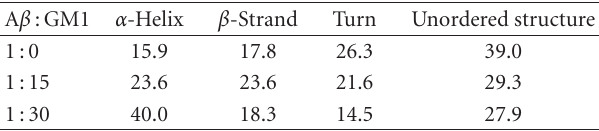
Table 1: Secondary structure contents (%) of A β (1–40) from VUVCD spectra obtained in the presence of varying concentrations of